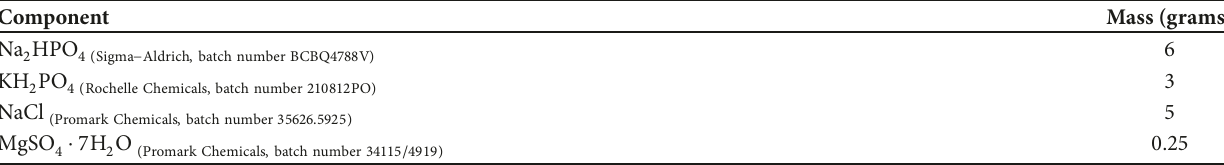
Table 1: Prepared amounts of salts added to one litre RO water to prepare M9-media (ISO 10872, 2010).